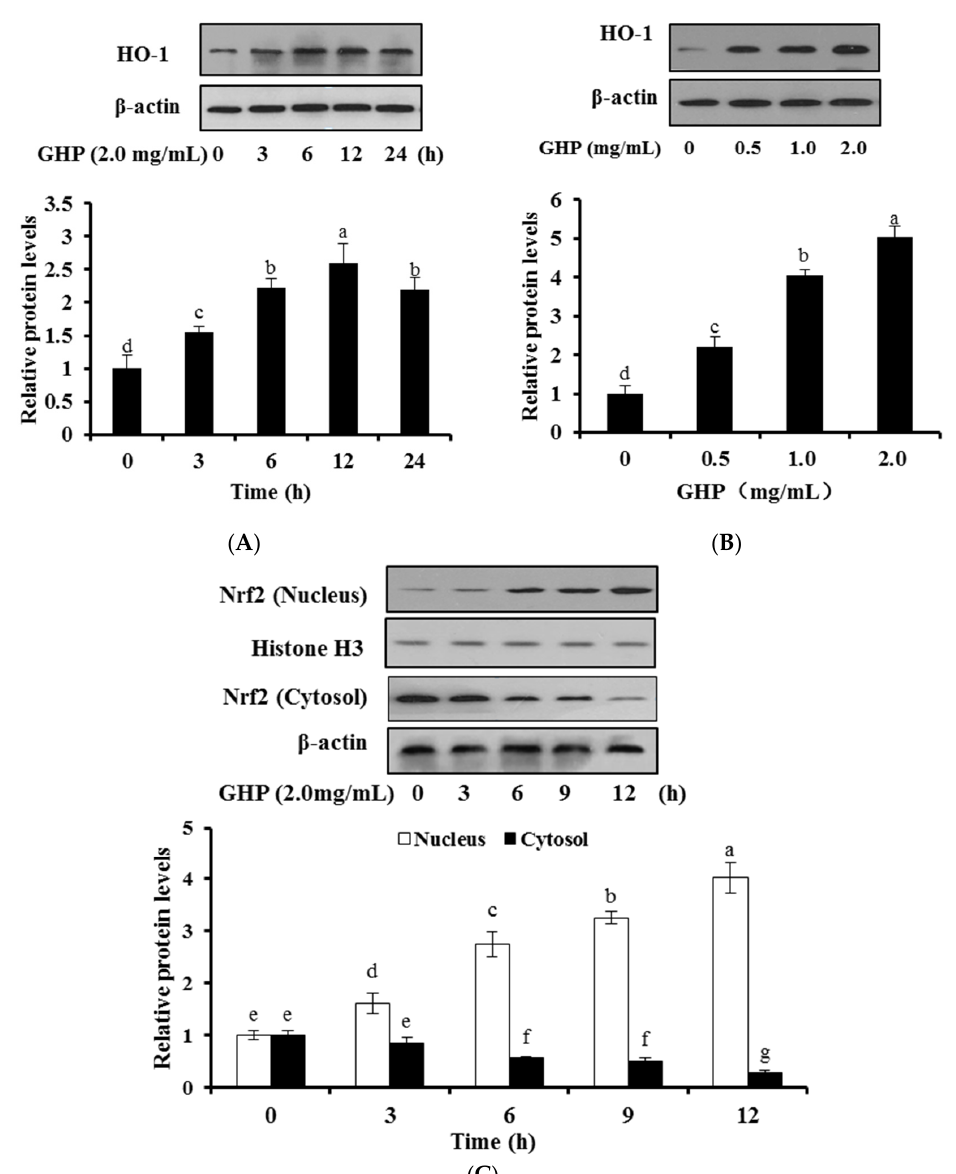
Figure 3. Effects of GHP on HO-1 expression and Nrf2 nuclear translocation in HepG2 cells. ( A ) Cells were treated with GHP (2.0 mg/mL) for indicated time periods; ( B ) Cells were treated with indicated concentrations (0, 0.25, 0.5, 1.0, or 2.0 mg/mL) of GHP for 12 h; ( A , B ) Cell lysates were prepared and determined by Western blot to analyze the levels of HO-1; ( C ) Cells were treated with GHP (2.0 mg/mL) for indicated periods. Cytosolic and nuclear fractions were prepared and determined by Western blot to analyze the levels of Nrf2. The results are presented as the means ± SD of three independent experiments. Means with different letters are significantly different from each other at p <